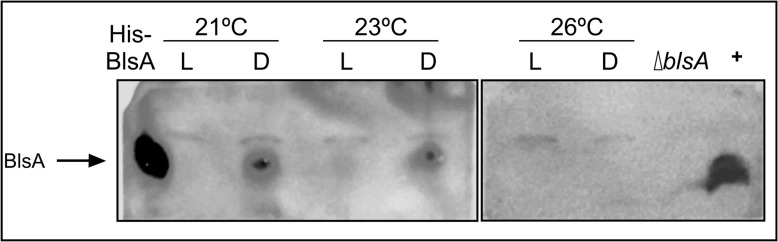
Effects of light and temperature on BlsA protein levels. Immunoblot analysis of protein samples from ATCC 17978 cells grown overnight in motility plates at 21, 23 or 26°C, in the presence of blue light (L) or in darkness (D), using purified antibodies directed against BlsA. Crude extracts corresponding to 350 μg of total proteins were loaded in each lane. His-BlsA refers to the purified recombinant BlsA protein, expressed as a His-tag fusion. (+) corresponds to the ΔblsA strain harboring plasmid pWHBlsA, which overexpresses a wild type copy of blsA directed by its own promoter.